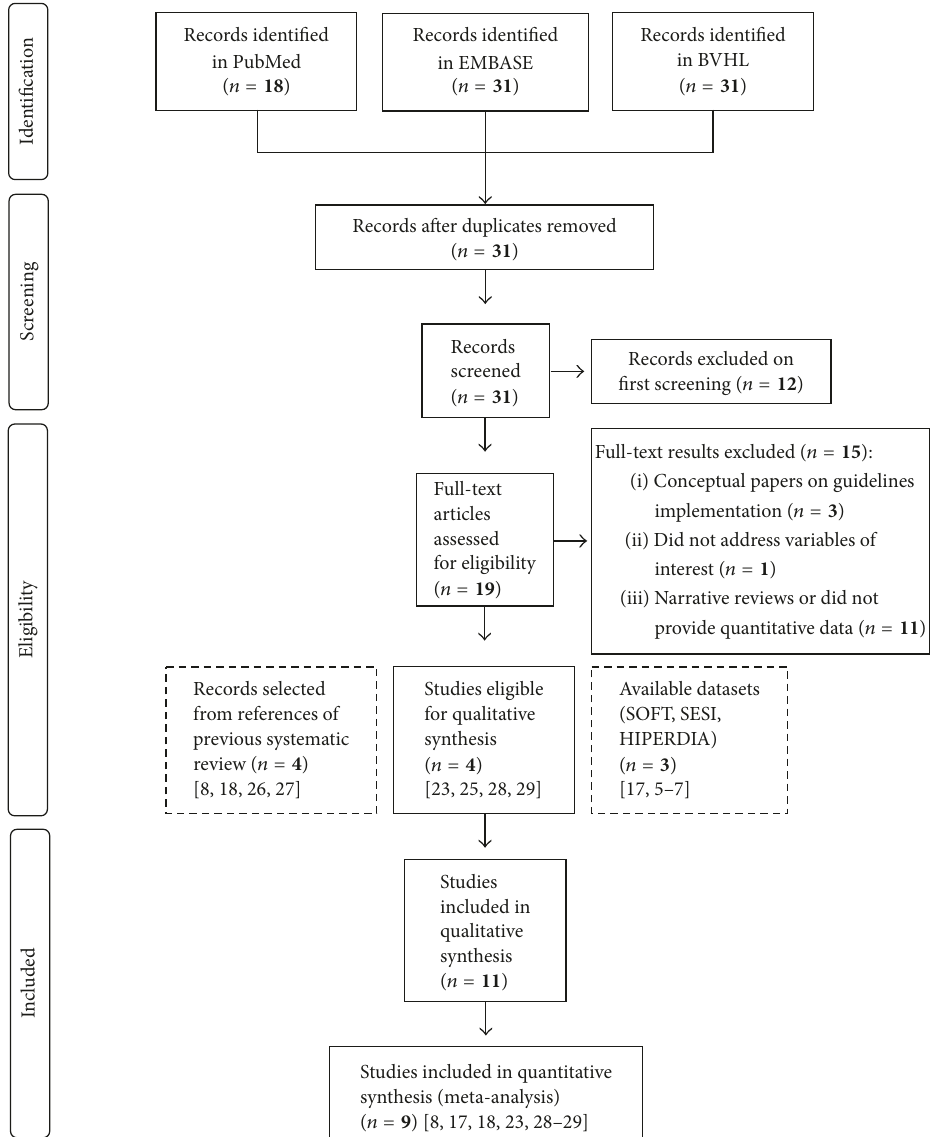
Figure 1: Flow chart of records retrieved, screened, and included in the systematic